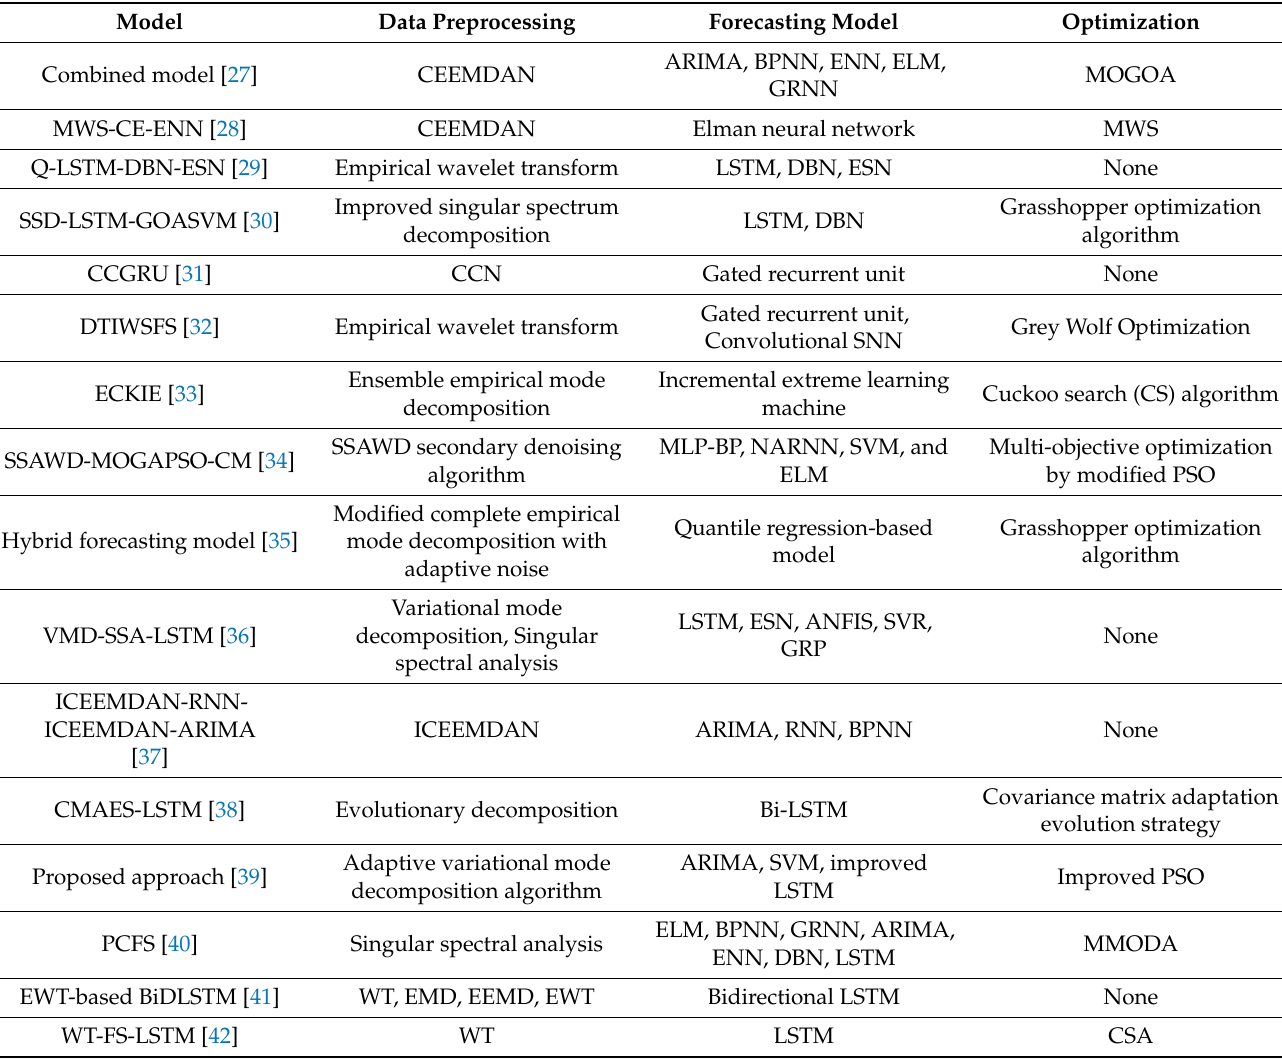
Table 1. The brief summary of the reviewed wind speed forecasting